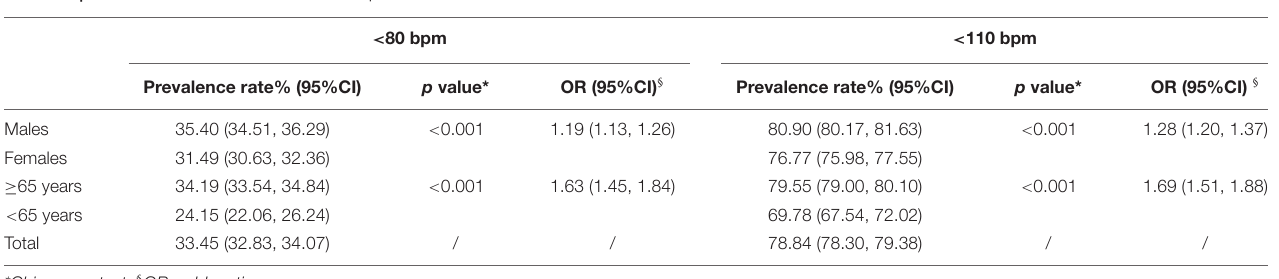
FIGURE 1 | Distribution of ventricular rate in patients with AF. (A) Distribution of ventricular rate of male patients with AF. (B) Distribution of ventricular rate of female patients with AF. TABLE 3 | Status of control of ventricular rate in patients with AF.